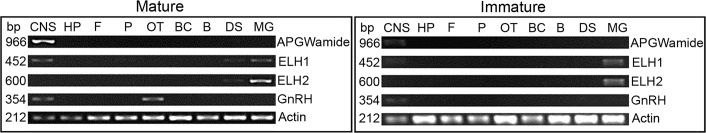
Representative RT-PCR gel showing tissue-specific expression of APGWamide, ELH and GnRH precursor genes in T. pisana.Tissues were derived from mature (n = 10) and immature (n = 15) snails. Tissues used include the: bursa tract (B), CNS (whole central nervous system ganglia), dart sac (DS), foot muscle (F), hepatopancreas (HP), mucous glands (MG), ovotestis (OT), penis (P). Tpi-actin was used as a positive control.